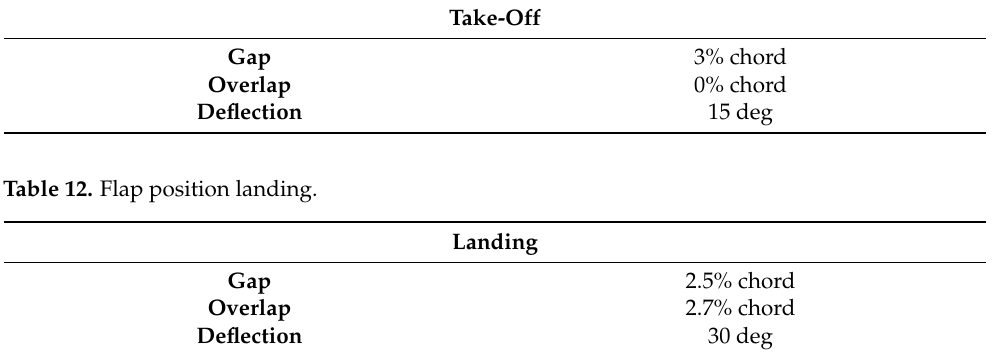
Figure 18. Numerical results of 3D simulations in terms of global lift coefficient for different flap positions, landing condition, M = 0.15, Re = 5.7 × 10 6 .